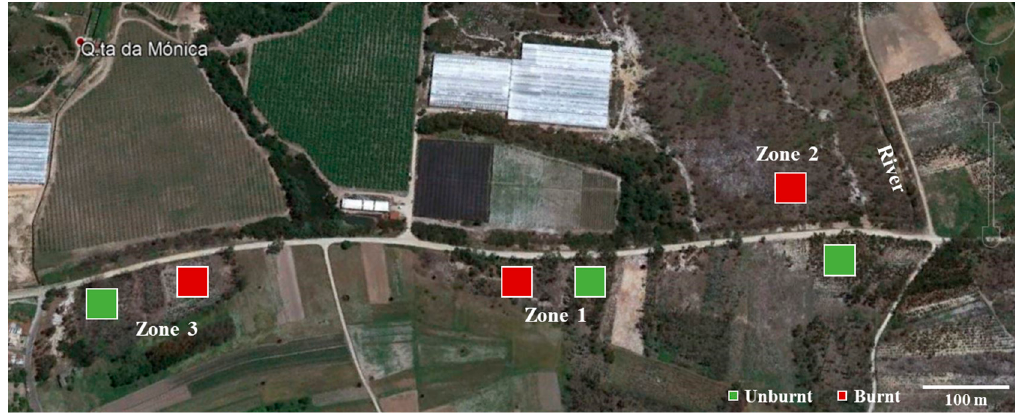
Figure 1. Schematic representation of the location of the six sampled sites: three unburnt zones (green) and three burnt zones (red). The 5 × 5 m plots were established to collect young plants and nodules.